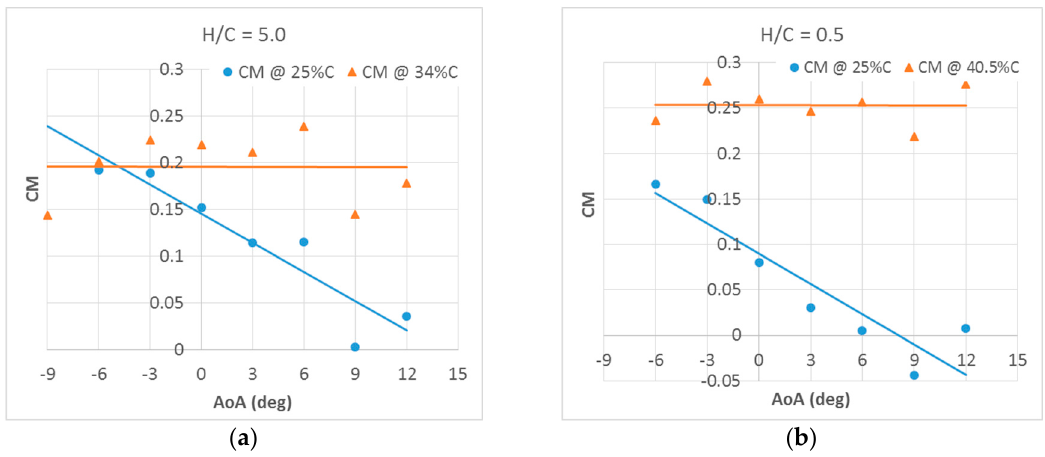
Figure 5. Moment coefficient vs angle of attack ( a ) at H/C = 5.0, ( b ) at H/C = 0.5.